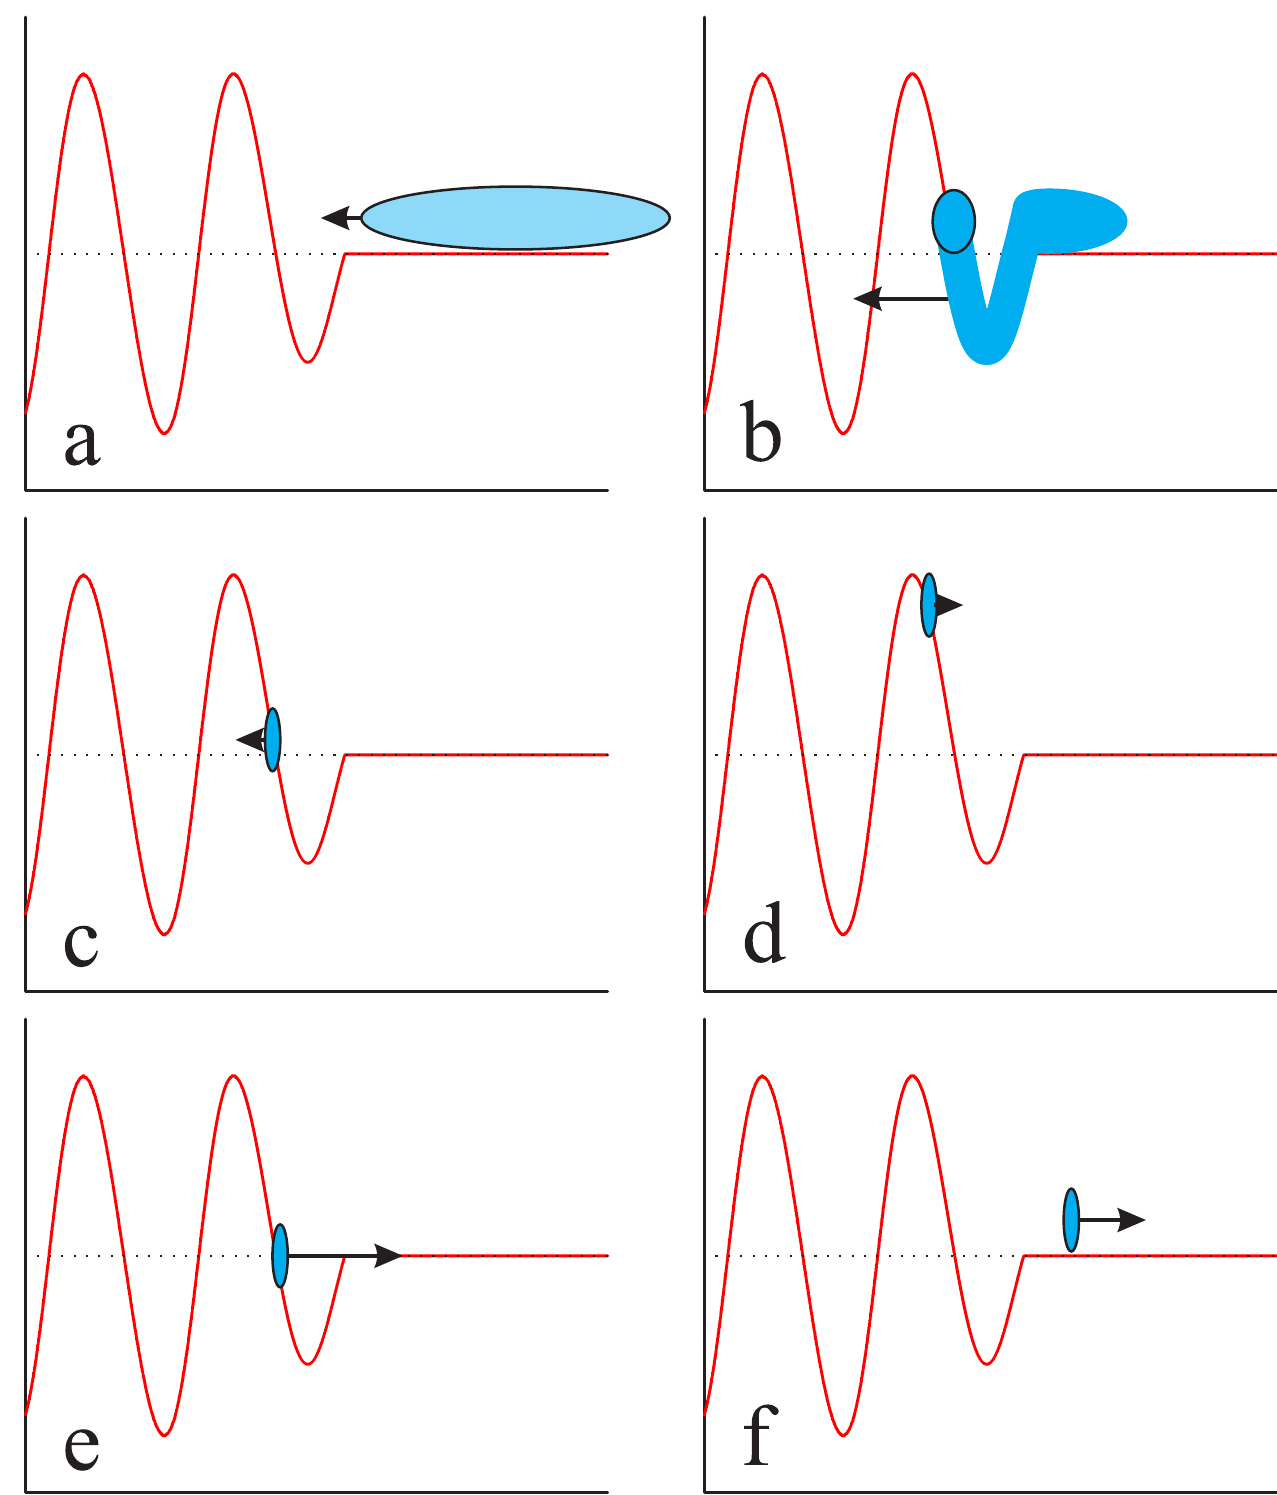
FIG. 1. (Color) Schematic representation of the plasma-compressor scheme in the calculated fields (see model in Sec. III) of the plasma wave: (a) the electron bunch just before the plasma wave overtakes it; (b) the rear part of the electron bunch is decelerated by the front of the plasma wave and gets compressed; (c) the electron bunch is compressed and gets accelerated; (d) the electrons start outpacing the plasma wave while still being accelerated; (e) the electrons get decelerated again by the plasma wave; (f) the compressed bunch leaves the plasma